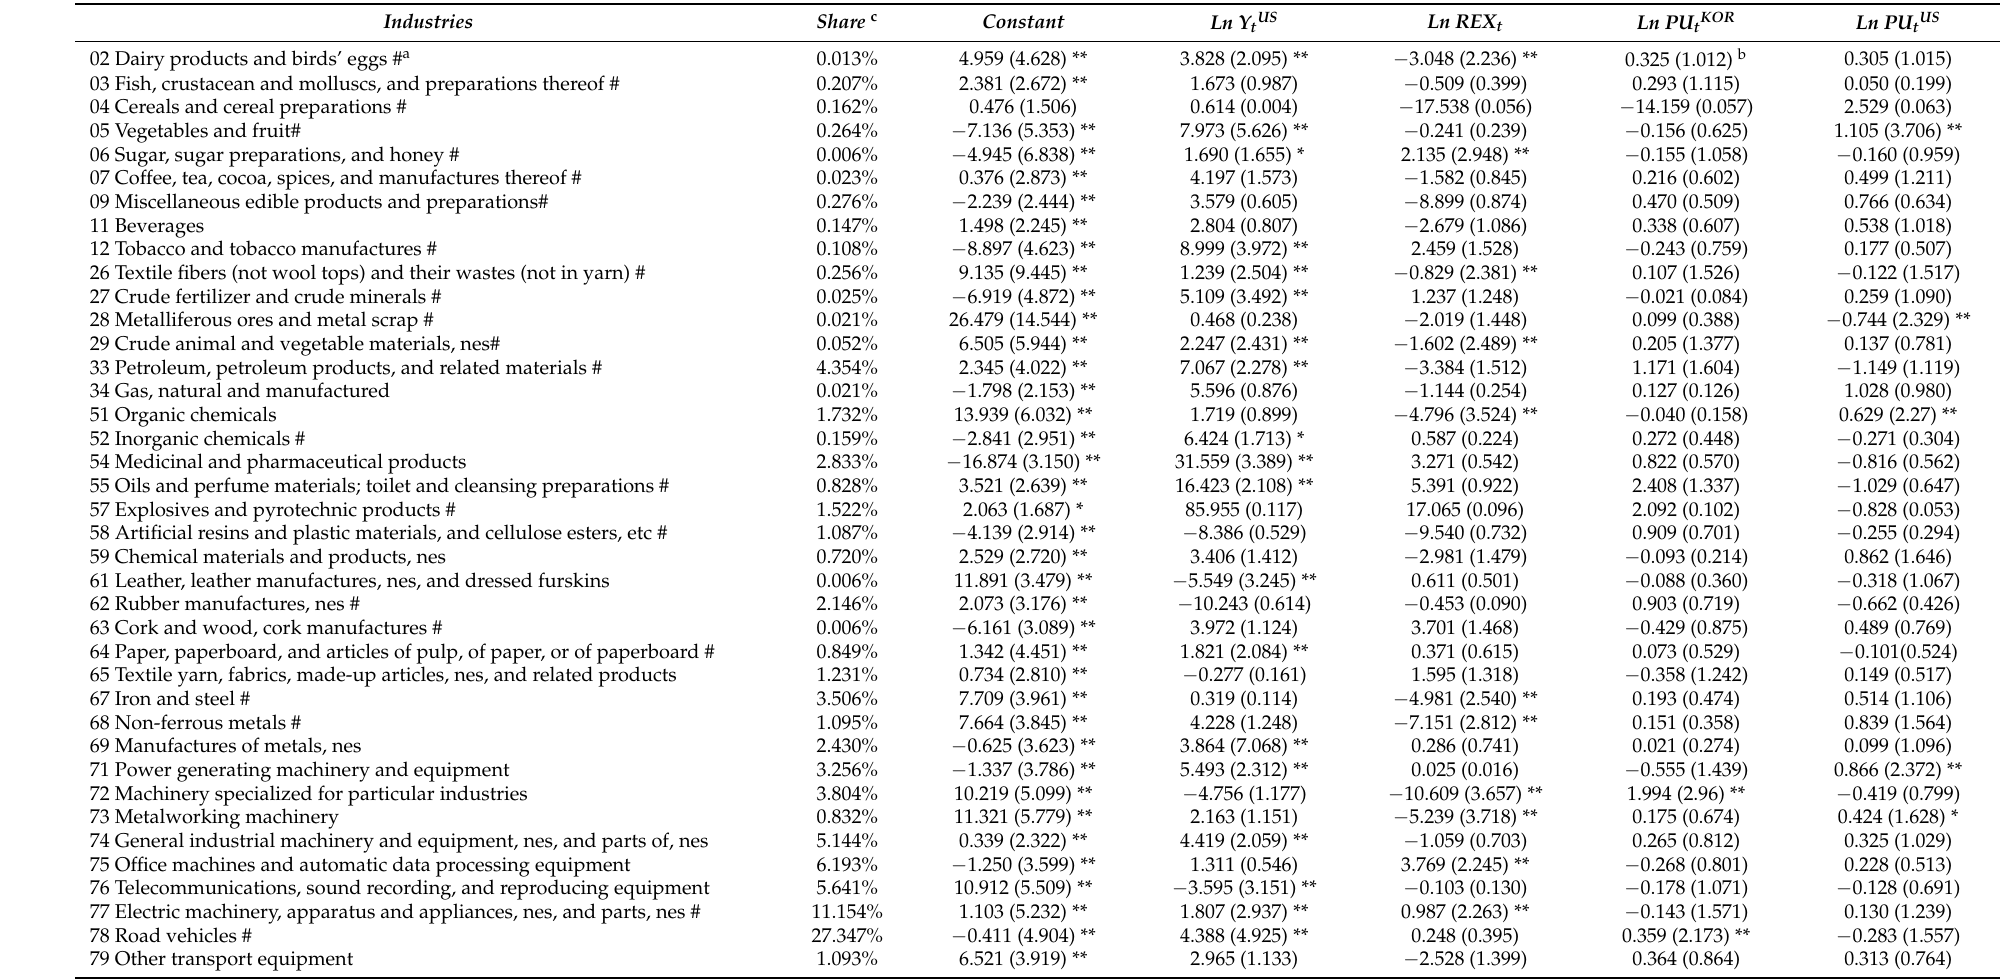
Table 7. Long-run coefficient estimates of U.S. import